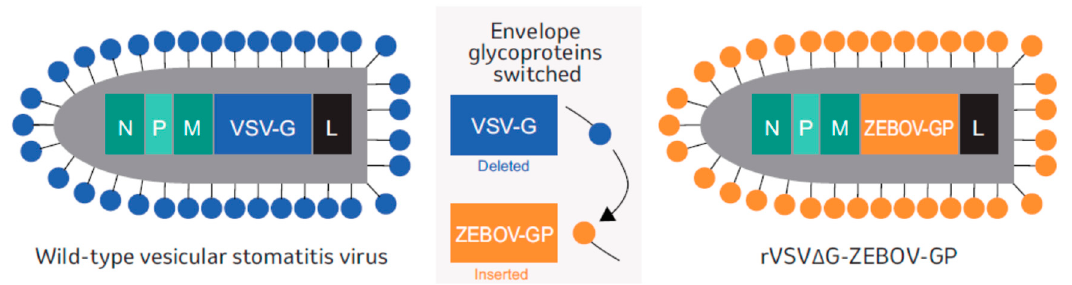
Figure 2. Molecular structure of the chimeric rVSV Δ G-ZEBOV-GP live, recombinant vaccine compared with wtVSV. L, large protein. M, matrix protein. N, nucleoprotein. P, phosphoprotein. VSV-G, vesicular stomatitis virus envelope glycoprotein. ZEBOV-GP, Ebola virus envelope glycoprotein.